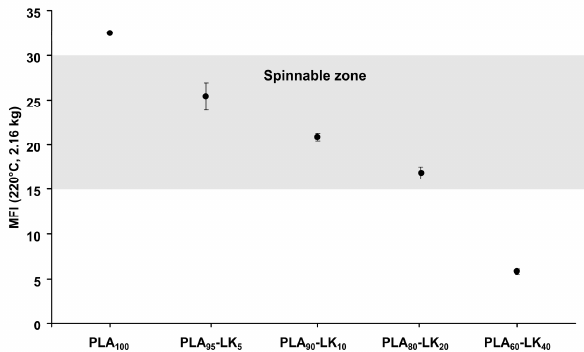
Figure 1. Melt flow index (MFI), (220 ◦ C, 2.16 kg) of PLA and PLA-LK pellets.